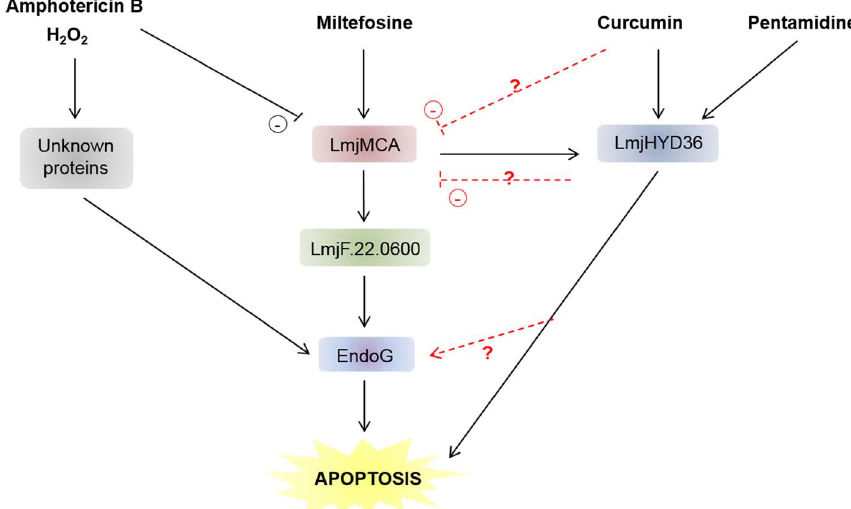
Figure 4. Proposed model of the different L. major cell death pathways. It is currently clear that different pro-apoptotic stimuli can induce different cell death pathways in L. major . While miltefosine induces LmjMCA and then LmjHYD36 and LmjF.22.0600 activation before activating EndoG, the amphotericin B and H 2 O 2 -induced cell death pathways involve unknown proteins. Curcumin and pentamidine, on the contrary, only activate LmjHYD36. The relationships between curcumin and LmjMCA and between LmjHYD36 and LmjMCA, on the one hand, and EndoG on the other, remain to be